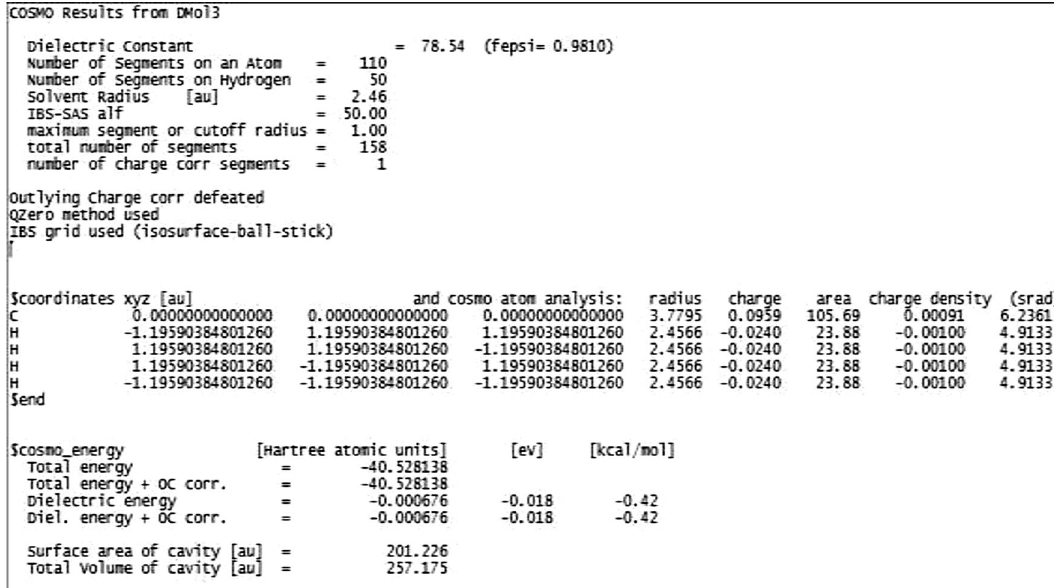
Figure 1. A schematic view of the COSMO file for